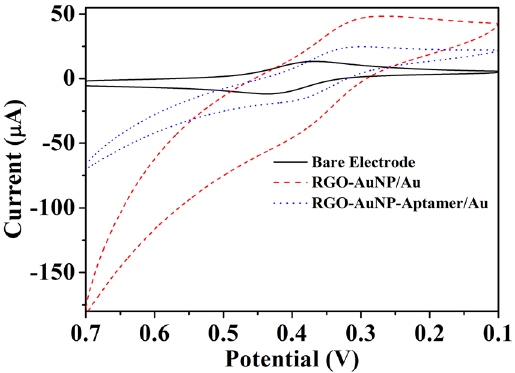
Figure 2. Cyclic voltammograms of the different Au electrodes in 5 mmol L − 1 [Fe(CN) 6 ] 3 − /4 − ( a ) Bare Au electrode (black line, solid line), ( b ) RGO-AuNP/Au electrode (red line, dashed line) and ( c ) RGO-AuNP- Aptamer/Au electrode (blue line, dotted line).